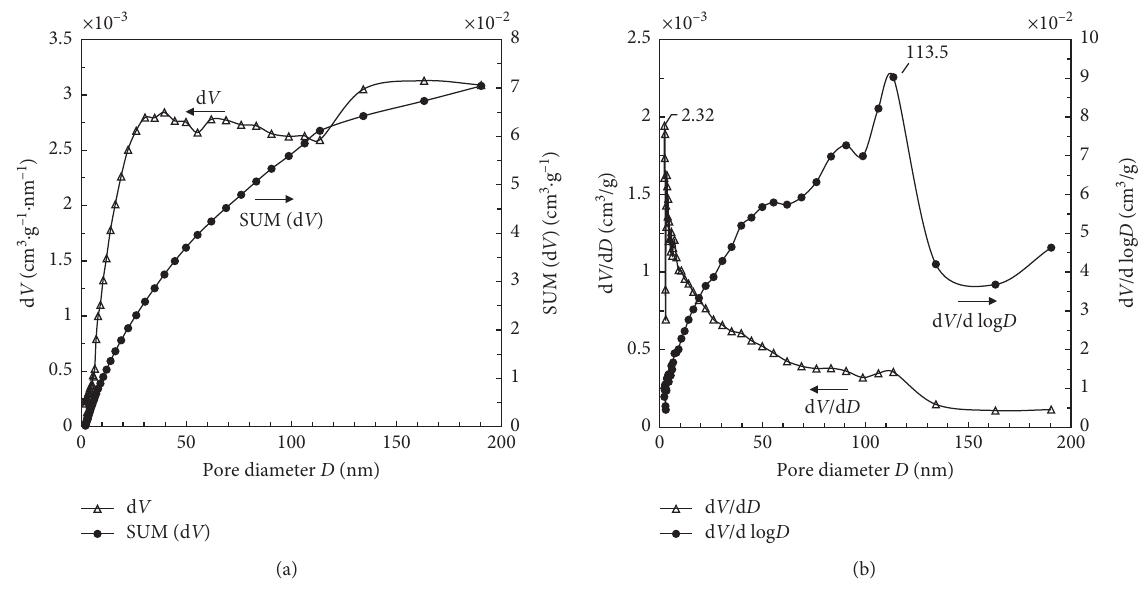
Figure 8: The pore-diameter distribution of NCG concretion by BET test. (a) d V and SUM (d V ). (b) d V /d D and d V /d log D .